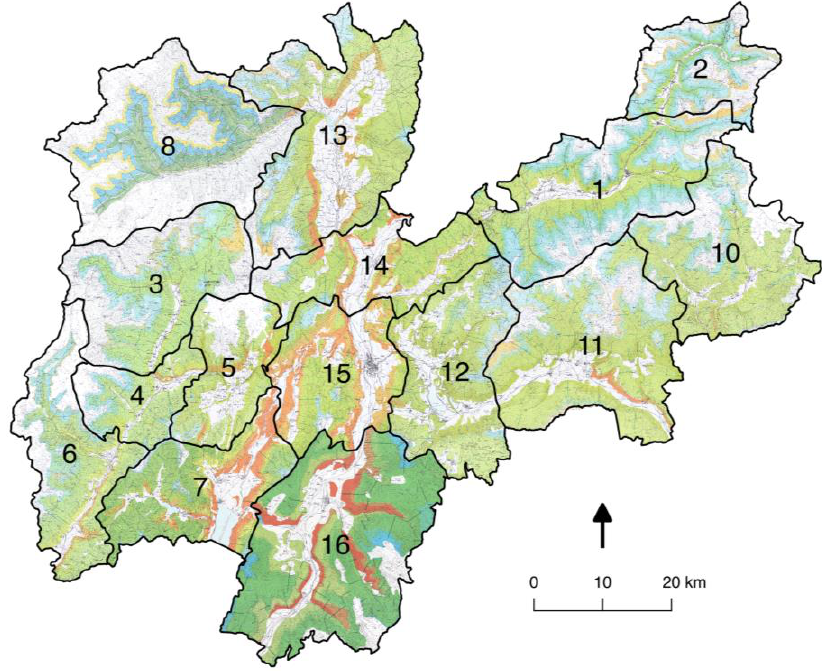
Figure 2. Territorial division of the Province of Trento in 16 zones.